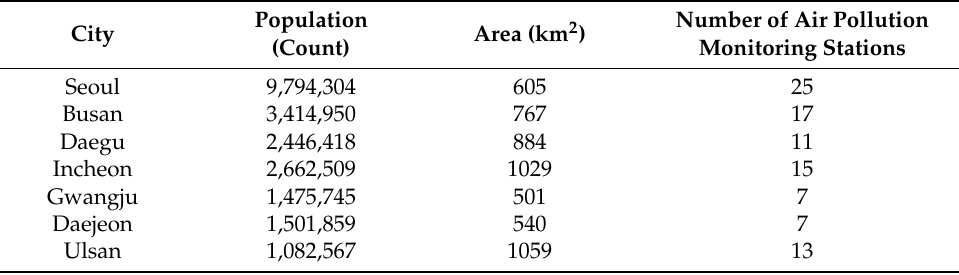
Table 1. Descriptive information for the seven major cities of Korea in 2010. Population Number of Air Pollution City Area (km 2 ) (Count) Monitoring Stations Seoul 9,794,304 605 25 Busan 3,414,950 767 17 Daegu 2,446,418 884 11 Incheon 2,662,509 1029 15 Gwangju 1,475,745 501 7 Daejeon 1,501,859 540 7 Ulsan 1,082,567 1059